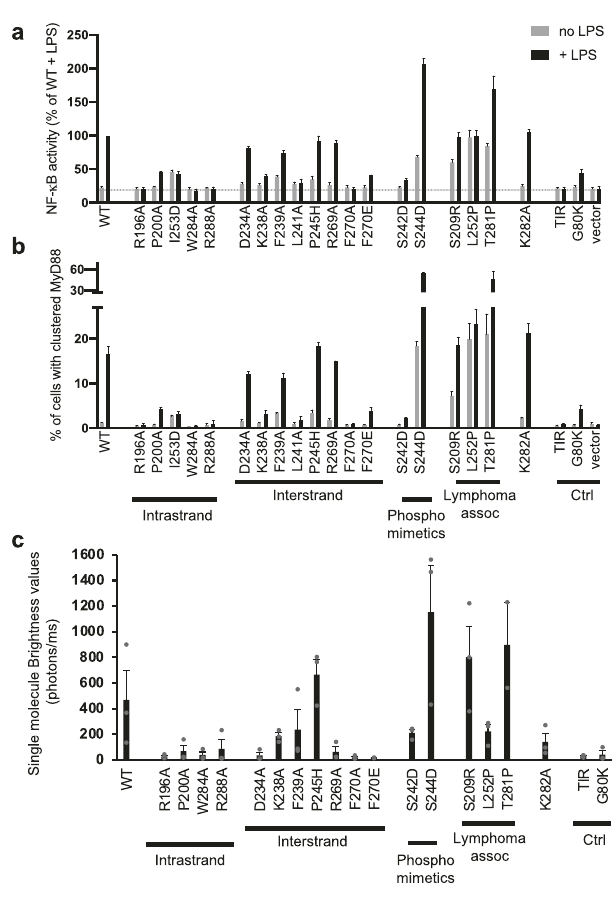
Fig. 6 Interface, disease-associated and phosphomimetic mutations modulate MyD88 signaling and assembly. a , b Effects of MyD88 muta- tions on LPS-induced signaling and MyD88 clustering were tested in HEK293 cells expressing TLR4, MD2 and CD14, with MYD88 knocked out and stably transfected with an NF- κ B-driven mScarlet-I fl uorescent reporter. The cells were transfected with plasmids expressing wild-type or mutant V5-tagged MyD88, or empty vector, and then treated with (black bars) or without (grey bars) LPS (100 ng/mL) overnight, immunostained to detect MyD88-V5 and analysed by fl ow cytometry. Cells with very low expression of MyD88 were used for analysis to avoid spontaneous signaling (Supplementary Fig. 5b, c). The mean ± range from n = 2 independent experiments is shown. The death-domain mutation G80K, which has previously been shown to prevent MyD88 clustering 130 , and a TIR domain alone construct provided negative controls. a NF- κ B activation measured by the geometric mean fl uorescence intensity of the mScarlet- positive population relative to LPS-treated cells expressing wild-type MyD88. The dotted line indicates level of activation in cells with empty vector. b The percentage of cells with clustered MyD88 was determined based on the elevated height-to-area ratio of the MyD88 signal, which is observed when MyD88 clusters 2 (Supplementary Fig. 5e). c Wild-type MyD88 and mutants were expressed in a cell-free system with an N- terminal GFP tag and the fl uorescent samples were analysed by single- molecule spectroscopy on a home-made confocal microscope. To characterize the propensity of wild-type MyD88 and mutants to form higher-order assemblies, the average brightness values (equation (1)) of the proteins were calculated 72 . The results show that S209R, S244D, P245H and T281P mutants have higher propensity than wild-type MyD88 to oligomerize. The mean ± SEM of n = 3 or n = 2 (F270E and T281P) experiments using different lysate batches with two technical repeats per experiment is shown. The G80K mutant and the TIR domain were used as negative